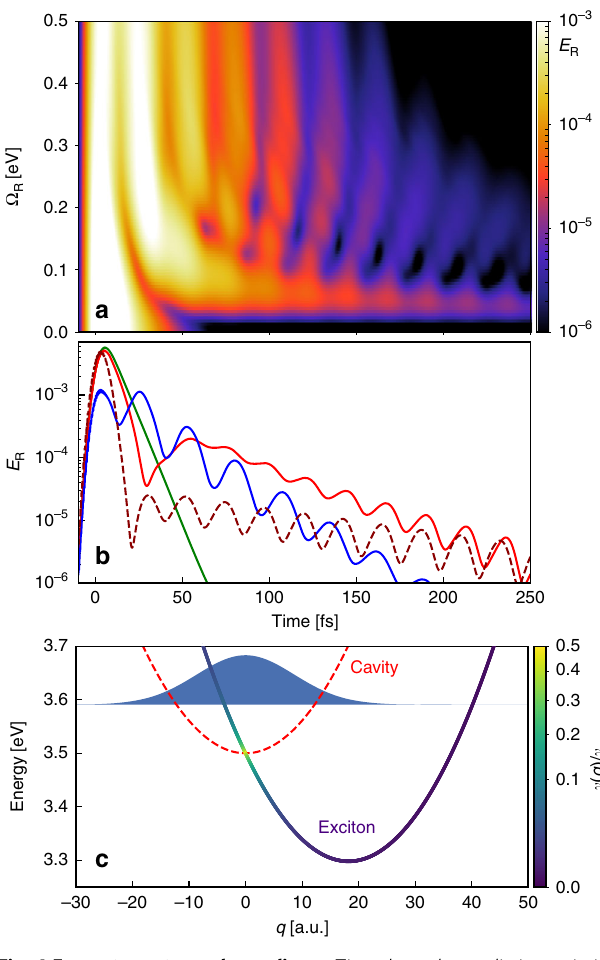
Fig. 4 From strong to weak coupling. a Time-dependent radiative emission from the cavity, E R , for different values of Ω R and laser frequency resonant with the bare lower polariton energy, ω L = ω e − Ω R /2. For all calculations, E = 2.1×10 − 7 a.u. and σ = 0.15eV. b Same as in a for three different values 0 L of Ω R = 0.01, 0.07, and 0.4eV (green, red, and blue lines, respectively). The dashed dark red line represents the case for Ω R = 0.07eV and a cavity with larger decay rate, γ c = 0.3eV. c Potential energy surfaces in the weak coupling regime with large Purcell enhancement of the emission. The red dashed line represents the PES of the molecule in its ground state with a photon in the cavity. The blue – yellow solid line represents the molecular excited-state PES with no photons present, with the position-dependent (Purcell-enhanced) decay rate encoded in the purple/yellow color scale. The fi lled blue curve represents the vibrational ground-state wavefunction of the electronic ground-state